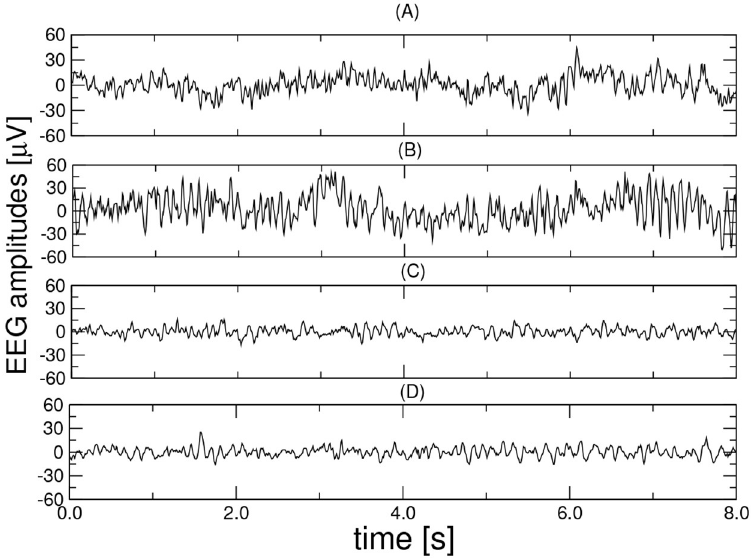
Fig 2. Exemplary EEG segments (channel F 7 ) from each of the four groups (A, B, C, and D). From top to bottom: health controls, eyes open (group A), health controls, eyes closed (group B), patient with AD, eyes open (group C) and patient with AD, eyes closed (group